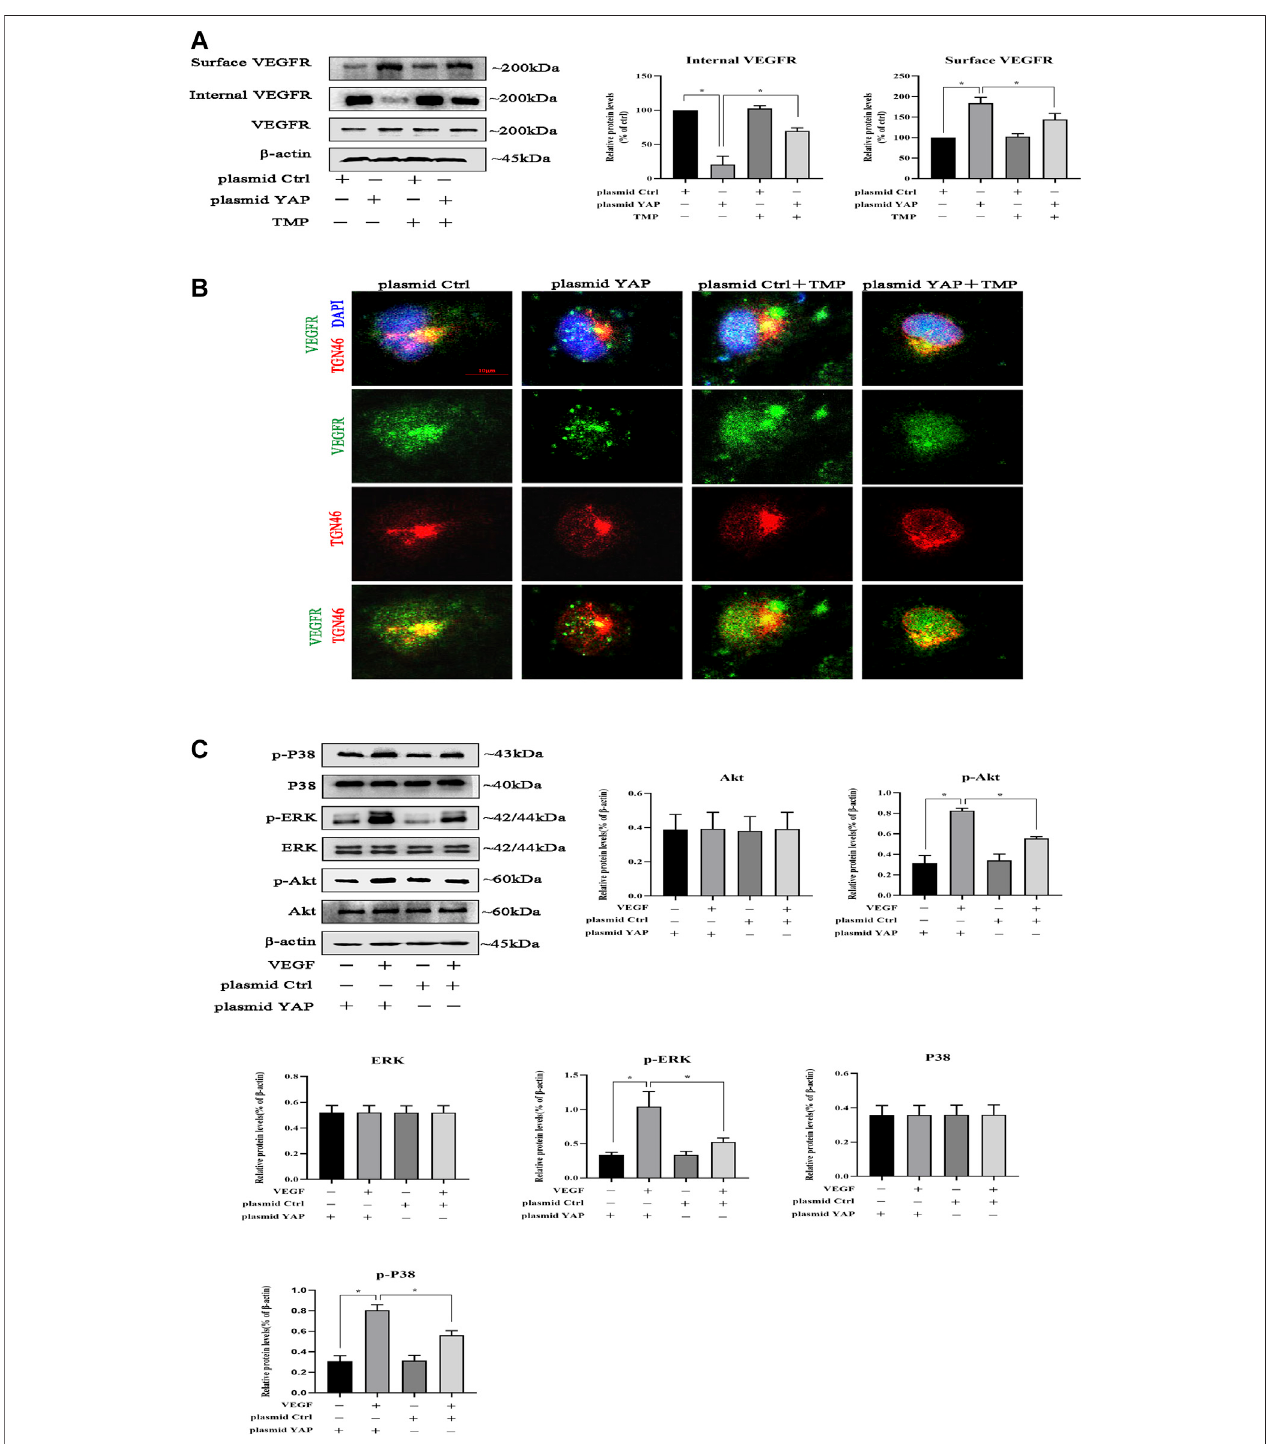
FIGURE8| EffectofTMPonVEGFRtraf fi ckingfromGolgitothecellsurface.HPVECsweretransientlytransfectedwiththecontrolplasmidandtheoverexpression YAP plasmid for 48 h and subsequently treated with TMP (40 μ M) or VEGF (50 ng/ml). (A) HPVECs were lysed using Subcellular Protein Fractionation Kit to obtain cytomembrane and intramembrane proteins. Western blottingassays wereused todetect cell surfaceand internal VEGFRexpression. (B) Immuno fl uorescence assays wereperformedtoobservetheVEGFRandTGN46(trans-Golginetwork[TGN]marker).RepresentativeimagesofVEGFRlocalizationintheTGNofthetransfected HPVECs (scale bars (cid:2) 10 μ m). (C) ) Representative blots for p-ERK, p-P38, and p-Akt were detected by western blotting assays, showing enhanced VEGFR downstream signaling in YAP overexpression cells. Data represent mean ± SEM (* p < 0.05).